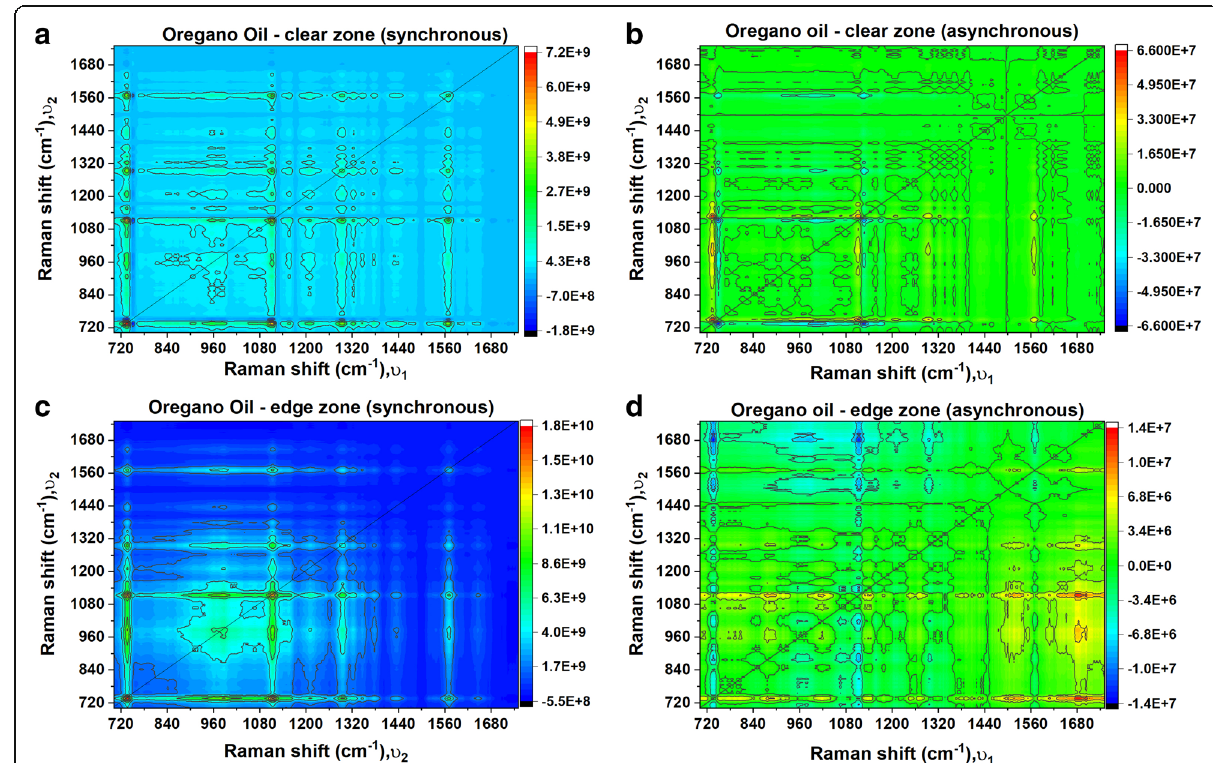
Fig. 7 Synchronous ( a , c ) and asynchronous ( b , d ) correlation spectra of clear and outer edge zone of bacterial cells exposed to oregano oil ranging concentrations from 0 to 30%. (Intensity colour scale on the